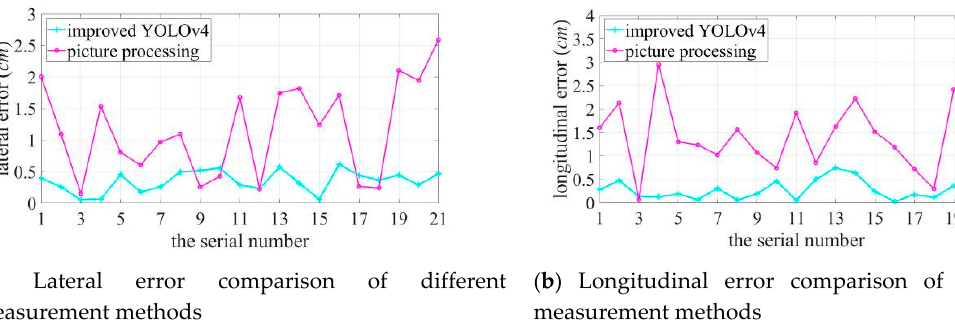
Figure 18. The error comparison of different methods.